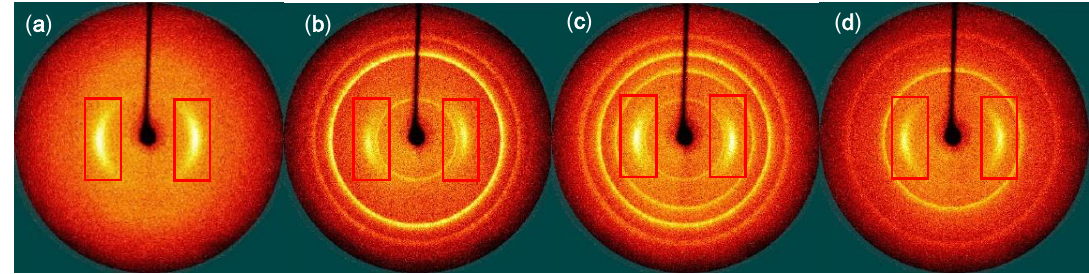
Figure 9. 2D WAXD patterns of the drawn fibers: ( a ) PANVDC, ( b ) PANVDC-ATO, ( c ) PANVDC-ATO/ZHS, and ( d ) PANVDC-ZHS.